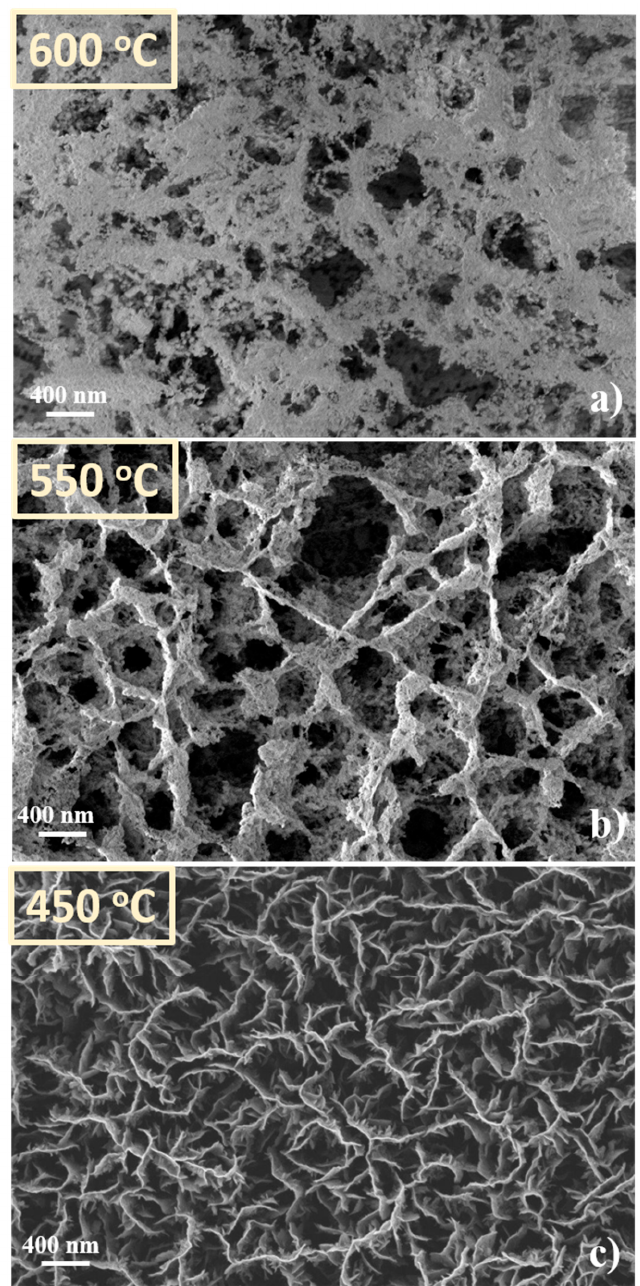
Figure 8. SEM images of CNW surface obtained after WO 3 decoration. Decoration obtained with plasma off at different temperatures ( a ) 600 °C; ( b ) 550 °C; ( c ) 450 °C; corresponding with the positions of the substrate in the furnace.